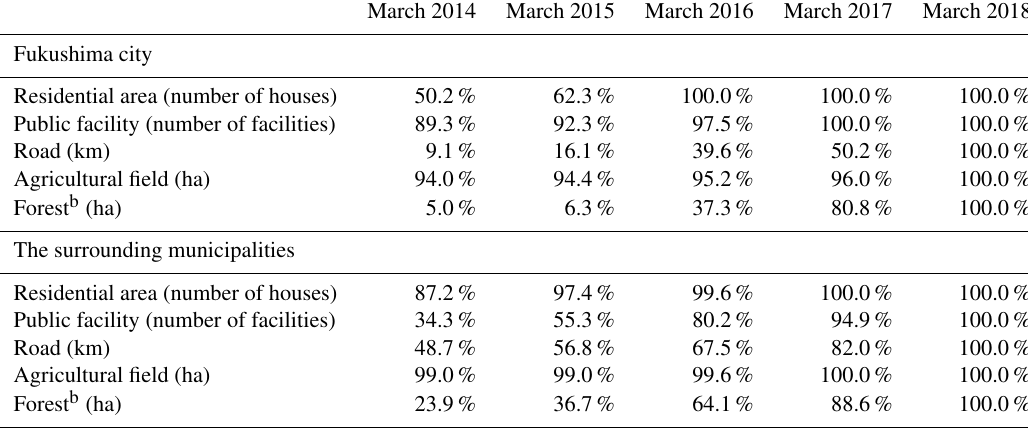
Table 1. Decontamination achievement ratios in Fukushima city and the surrounding municipalities (Nihonmatsu city, Kawamata town a , Date city, and Koori